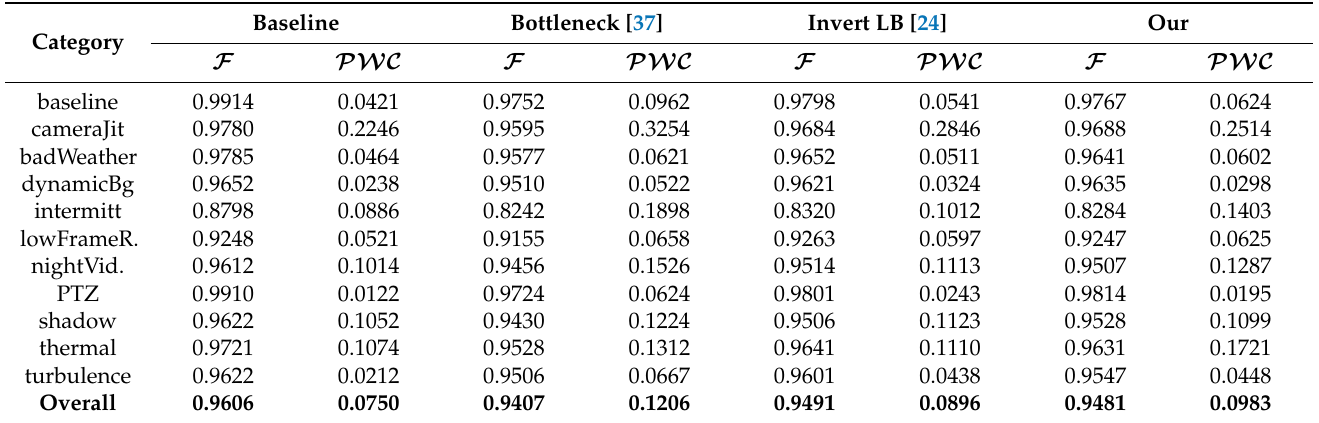
Table 5. Accuracy experimental results for different bottlenecks. The last row represents the average result for each scenario.